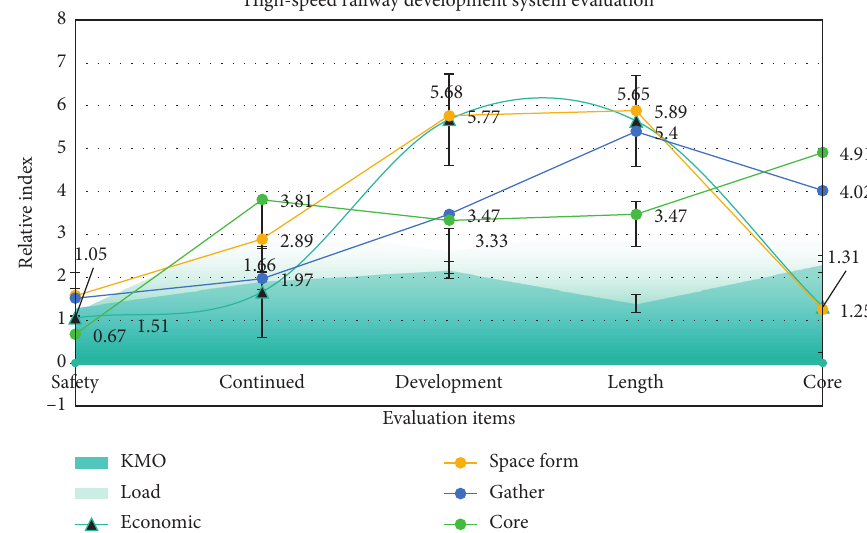
Figure 4: High-speed railway development system